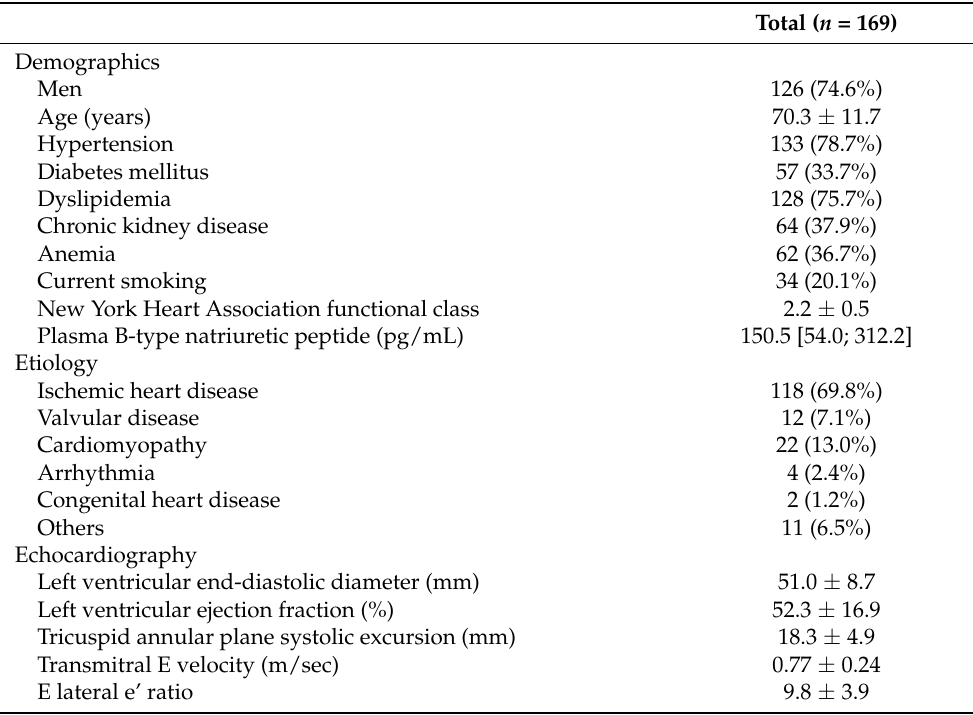
Figure 1. Distributions of AT ( A ) and PVO2 ( B ). Table 1. Baseline characteristics.